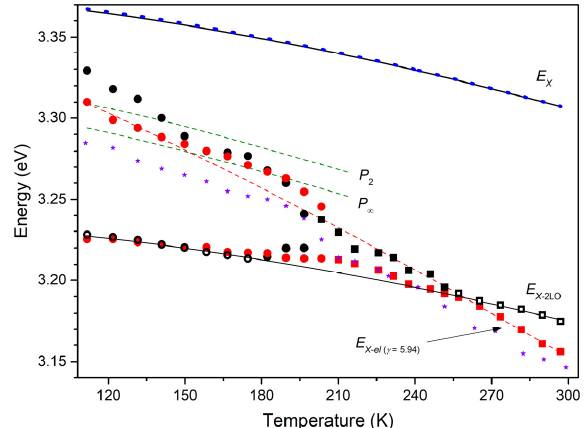
Figure 5. Temperature dependence of spectral bands’ maxima. Red and black symbols correspond to the experimentally observed emission bands in type I and type II spectra, respectively; circles and squares denote separate and merged emission bands (open symbols were used for fitting); stars correspond to the lasing band. Solid lines are fitted dependences for E X ( T ) (upper) and E X- 2LO ( T ) (bottom). Dashed lines indicate P 2 ( T ) and P ∞ ( T ) (4) (green), and E X-el ( T ) (5) with γ = 5.94 (red). E X ( T ) from [28] indicated with a blue dotted line.